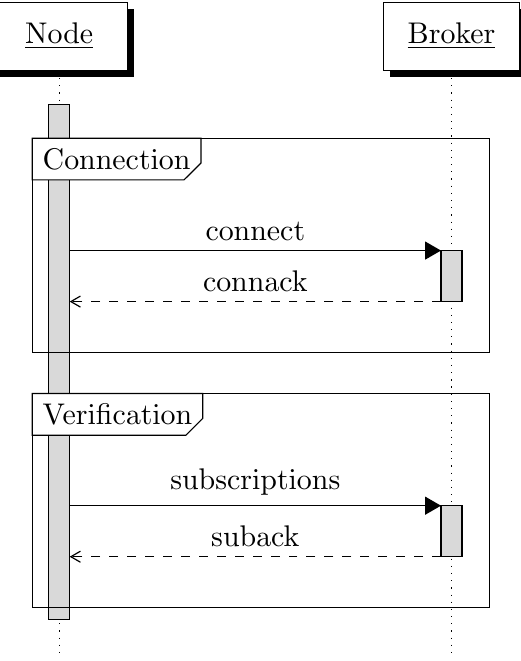
Figure 5. Connection procedure and security overhead in MQTTS. First, a secure connection with the broker is established and next the MQTT connection can be performed. Details on the connection and verification steps can be found in Figures 2 and 3; the composition of the packets in Tables 1–4.